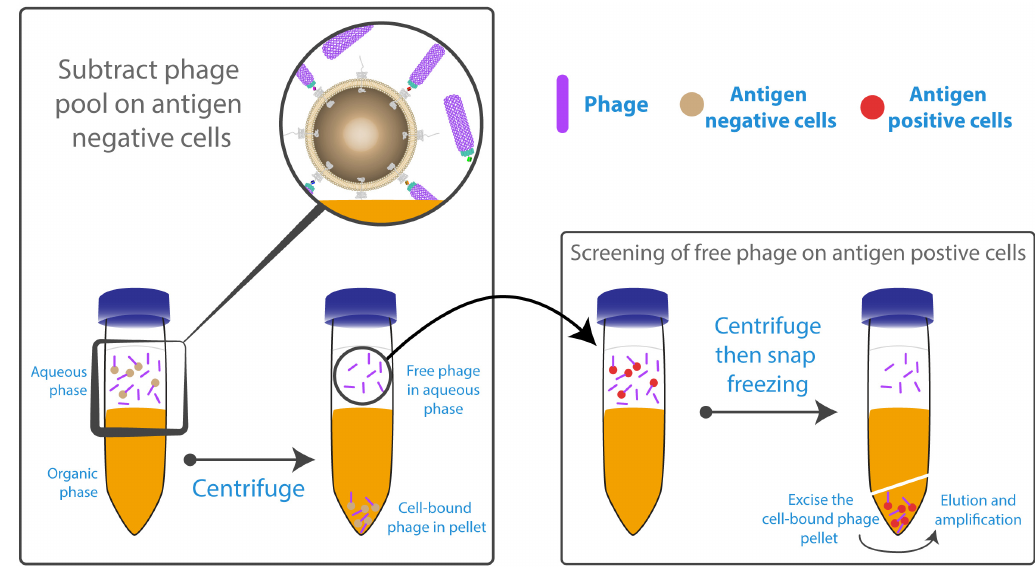
Figure 4. Whole cell ‐ based panning using Biopanning and Rapid Analysis of Selective Interactive Ligands (BRASIL). Panning started with a depletion step for the phage library on cells not expressing the antigen of interest. The phage/unwanted cells complex were centrifuged into the organic phase. Free phage within the aqueous supernatant are transferred and incubated with cells expressing the antigen of interest into the aqueous solution before centrifugation through the organic phase. Bound phage were rescued from the organic phase, and then amplified to be used for the subsequent panning rounds. Figure shows methodology described by Giordano et al. [126].